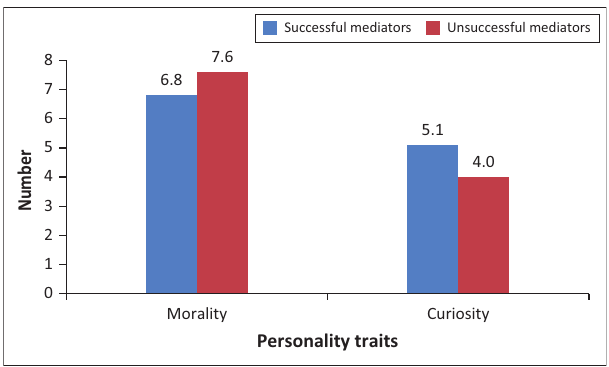
FIGURE 1: The expressiveness of personality traits of successful and unsuccessful